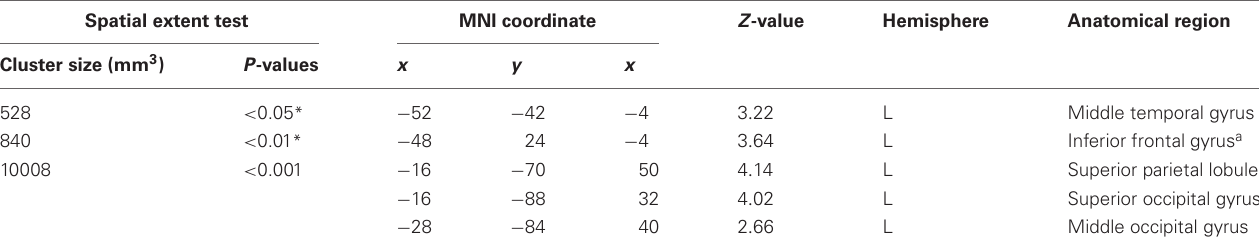
The threshold size of activation was P < 0.05, corrected for multiple comparisons, when the height threshold was set at Z > 2.58; x, y, and z are stereotaxic coordinates (mm). Hem, Hemisphere; L, left. * The search volume for activation was limited to each region activated by the sighted group.